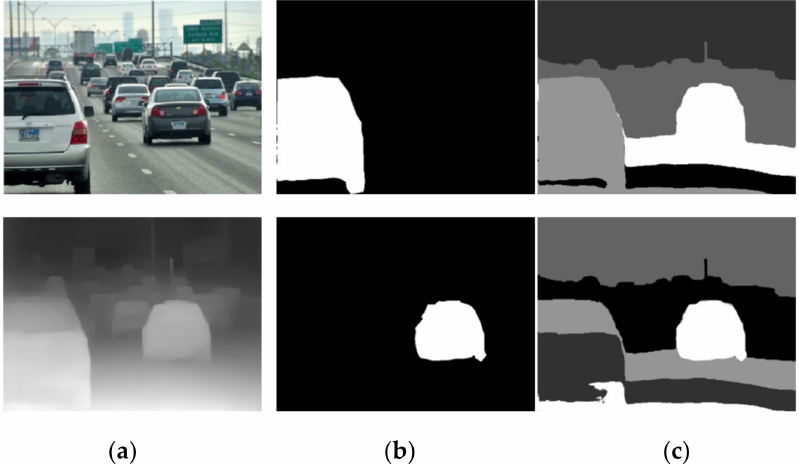
Figure 5. Different clustering results for the same image. ( a ) The first column shows the all-in-focus image and depth map. ( b ) The second column shows the different focal planes. ( c ) The third column shows the different clustering